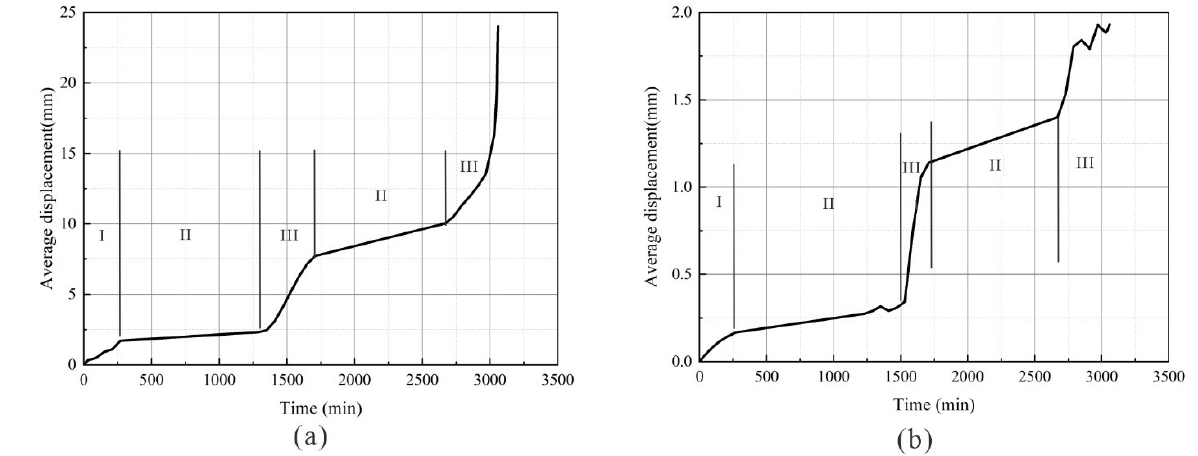
Figure 9. Average displacement magnitudes of the slope: ( a ) displacement of the slope front; and ( b ) displacement of the slope side.